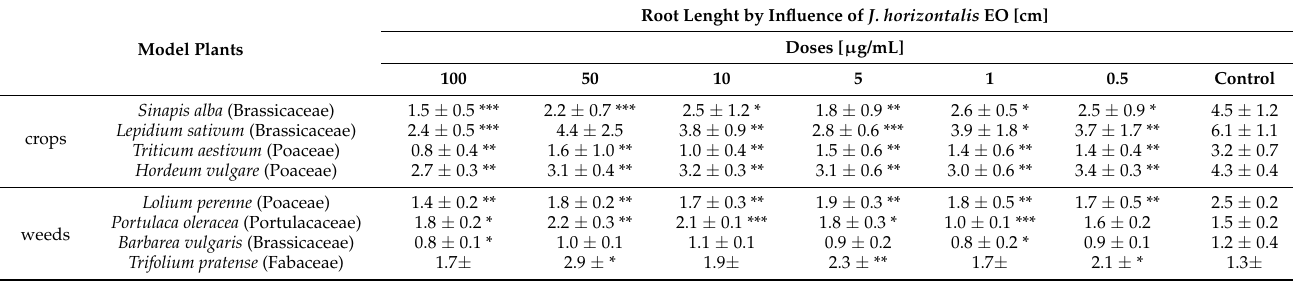
Table 3. Root length (cm) after 120 h from application of several doses of J. horizontalis EO. Results are reported as the mean ± SD of six experiments.